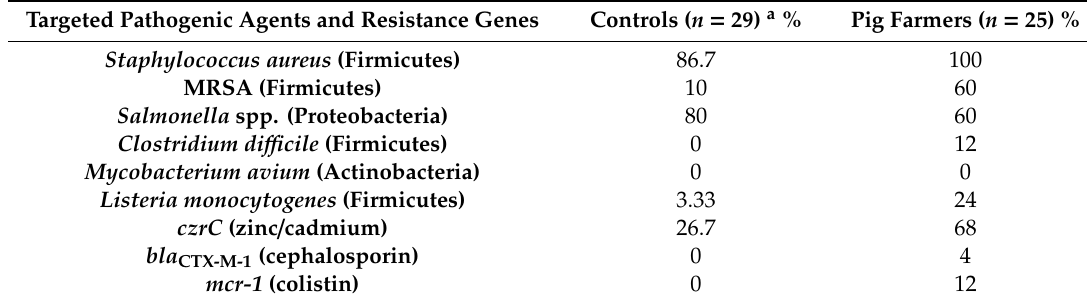
Table 2. Human pathogens and antibiotic and zinc resistance genes in the nasopharyngeal flora of pig workers compared to non-exposed